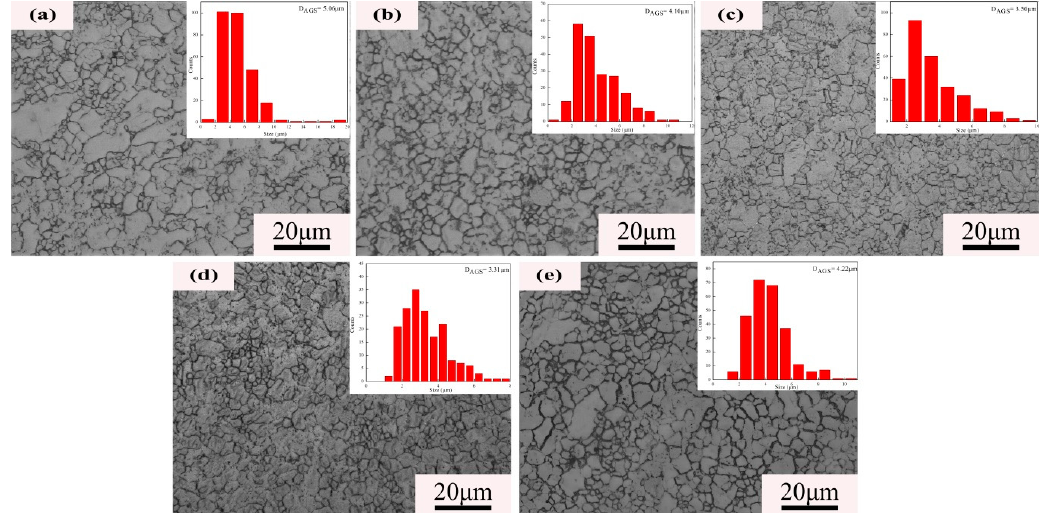
Figure 1. Optical microscopy (OM) of extruded Mg–5Zn–4Al–xSn alloys: ( a ) ZAT540, ( b ) ZAT540.5, ( c ) ZAT541, ( d ) ZAT542, and ( e ) ZAT543.